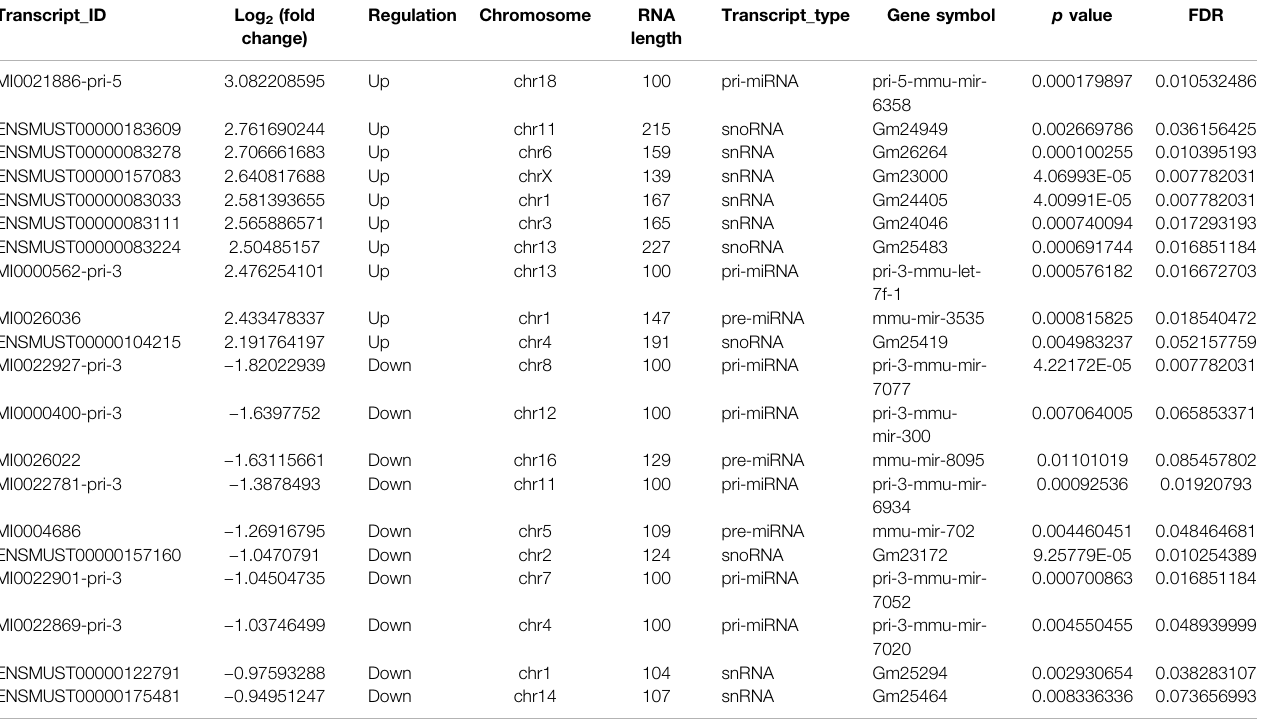
TABLE 4 | Top 20 differently methylated smallRNAs in the kidneys after cisplatin treatment. Log 2 (fold